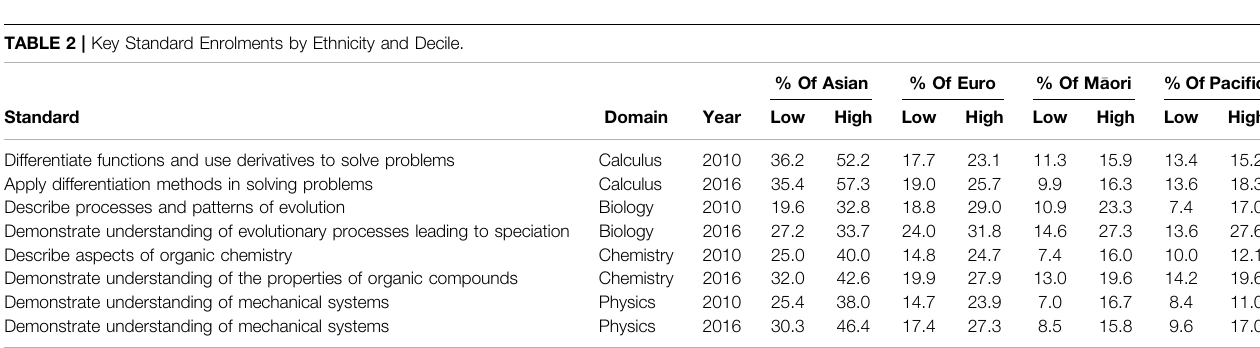
TABLE 2 | Key Standard Enrolments by Ethnicity and Decile.